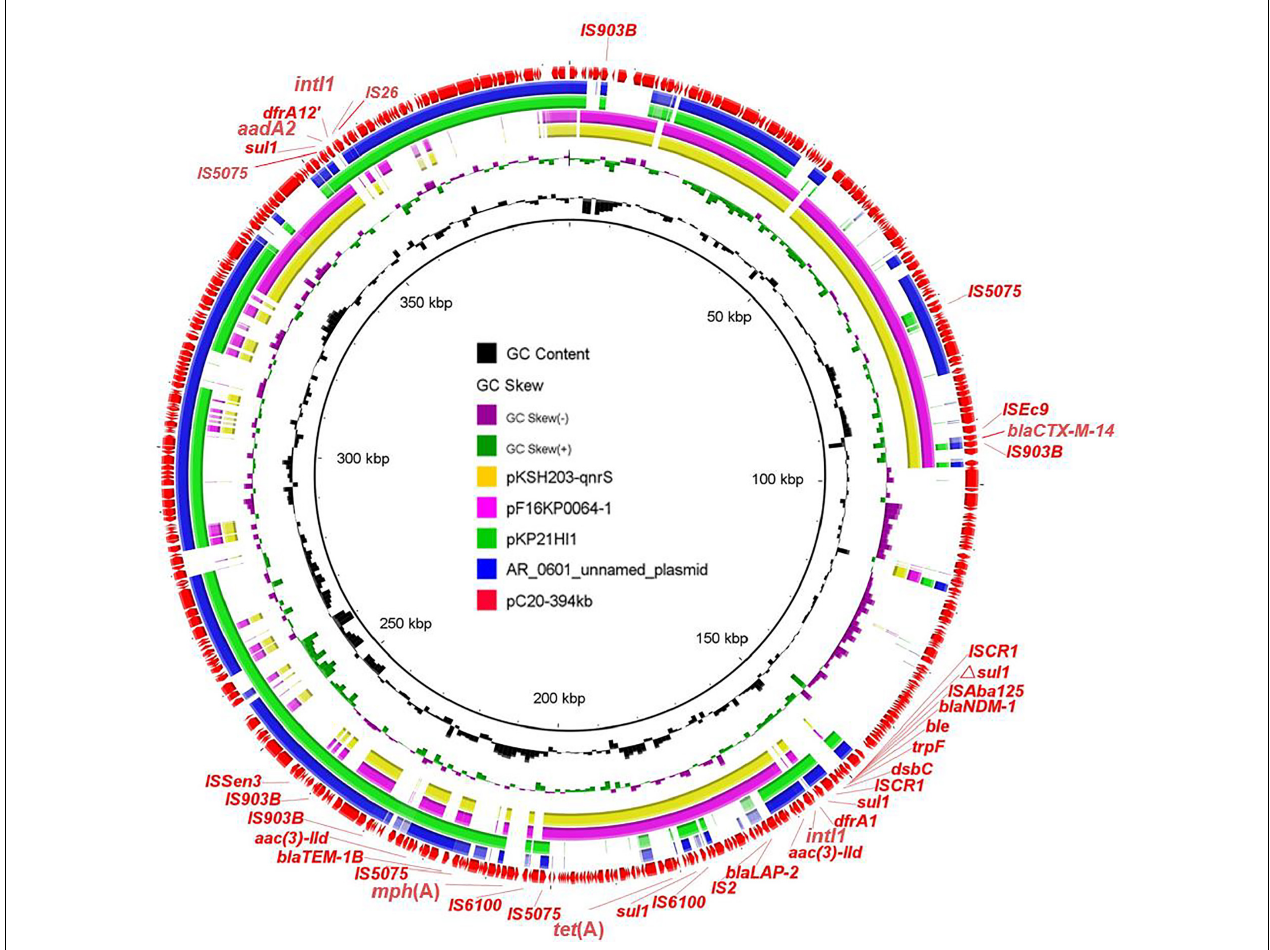
FIGURE 2 | Circular comparison of pC20-394 kb and four most related plasmids available in NCBI. The outmost circle shows the coding genes of pC20-394 kb.